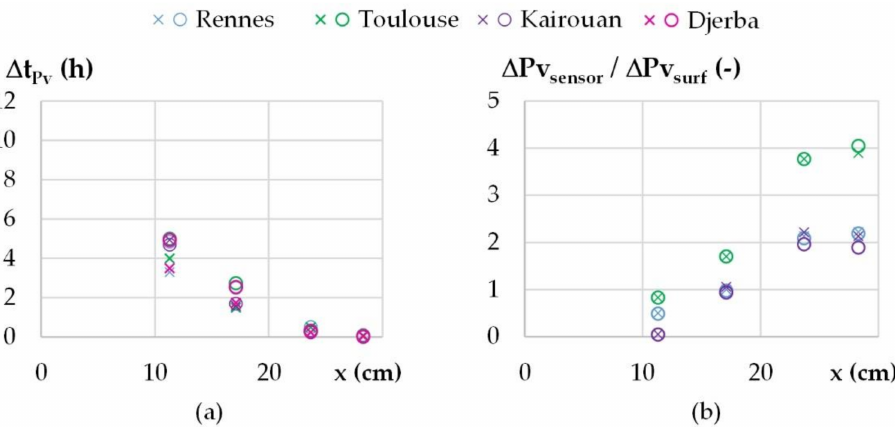
Figure 14. Dynamic hygric parameters versus location for all the cities ( × /o: calculated during increasing/decreasing vapor pressure step): ( a ) Shift of vapor pressure, ( b ) damping